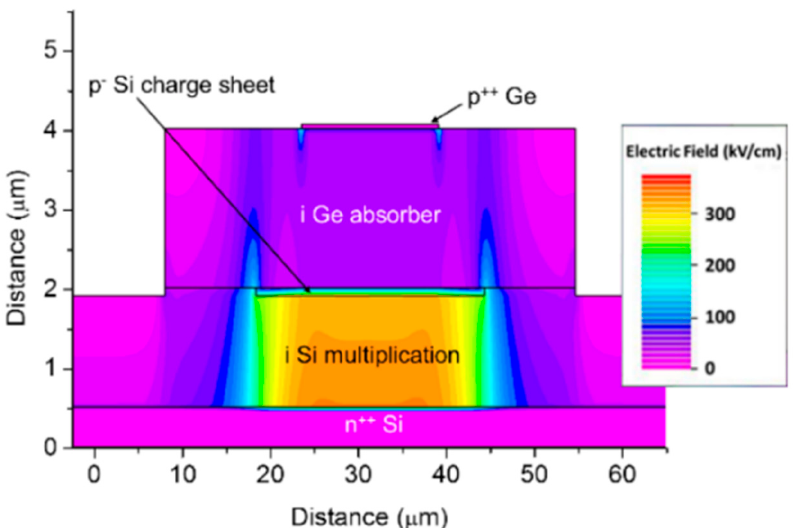
Figure 24. Electric field distribution for Ge/Si SPAD at 5% excess bias above the breakdown (the thickness of the Ge absorber is 3 μ m). Reproduced from [78], Springer Nature, open access, 2019.